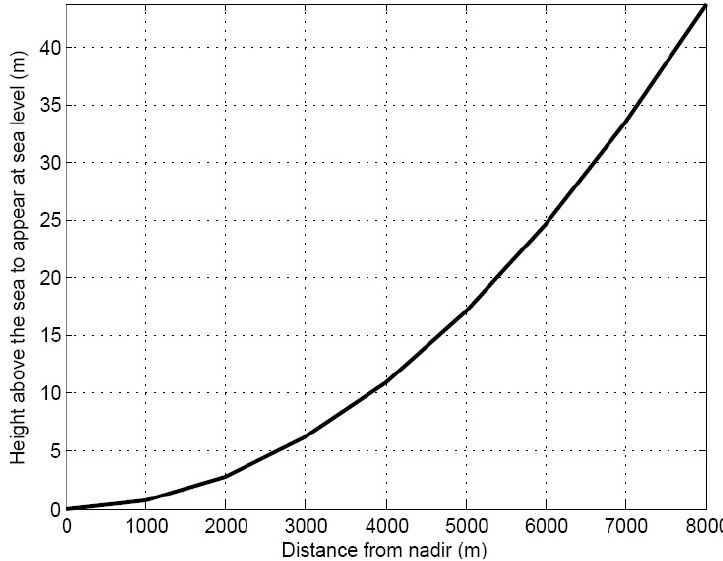
Figure 7. Relationship between distance from the satellite’s nadir of an observed target and its physical height in order to generate a simultaneous echo with the water at nadir.